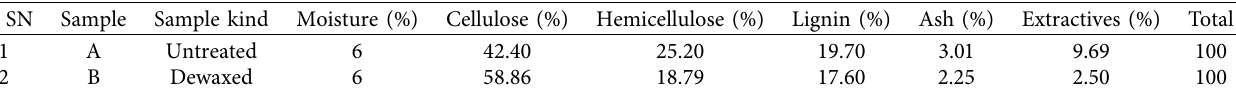
Table 1: Chemical composition of untreated and dewaxed sugarcane bagasse determined by the Chesson method of gravimetric analysis. SN Sample